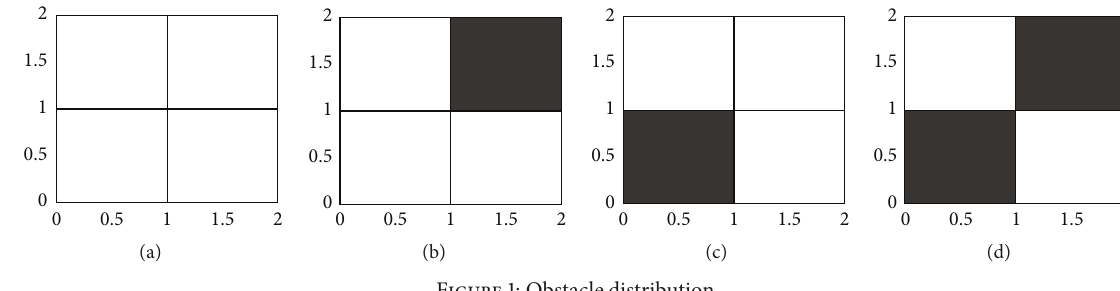
Figure 1: Obstacle distribution.